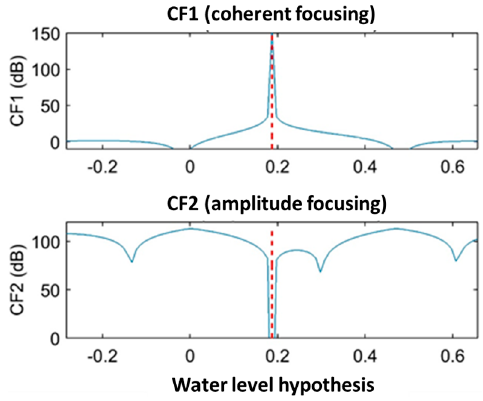
Figure 6. Calculation of the two cost functions described in Section 3.1 for the peanut-shaped lake example.